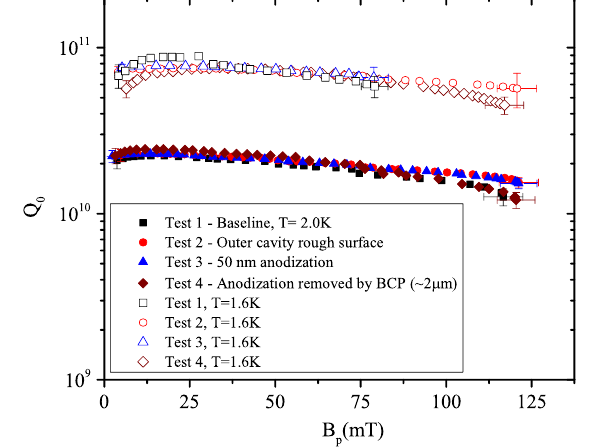
FIG. 5. Q 0 vs B p data for ingot Nb cavity TD5 at 2.0 K (solid symbols) and 1.6 K (empty symbols) after different outer surface modification. The rf measurement during tests 1 and 3 at 1.6 K was stopped at B p ∼ 75 in order to remain below the multipacting barrier.